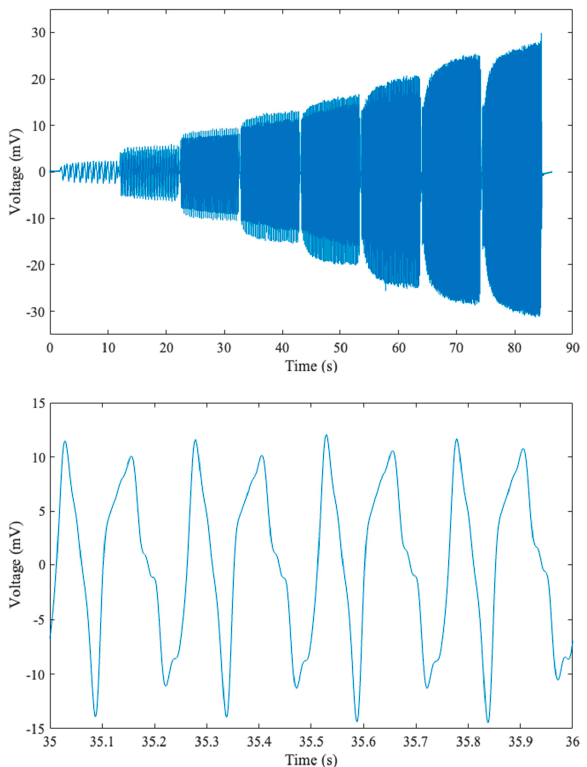
Figure 7. Voltage response versus time for 1 to 8 Hz cyclical testing in the Instron ( top ) and a zoomed-in version of the 4 Hz voltage response ( bottom ).